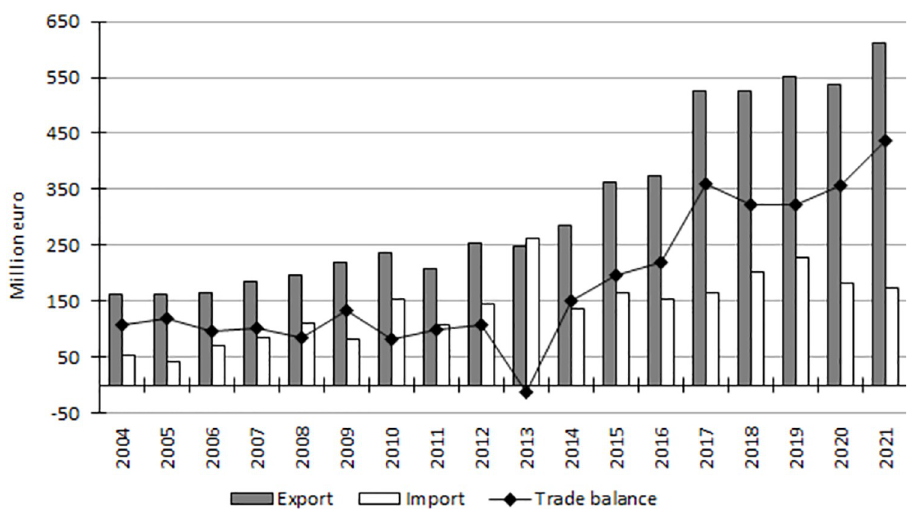
Fig 6. Poland’s foreign trade in agri-food products with the USA in 2004–2021 (million euro). Source: [13], the authors’ elaboration.